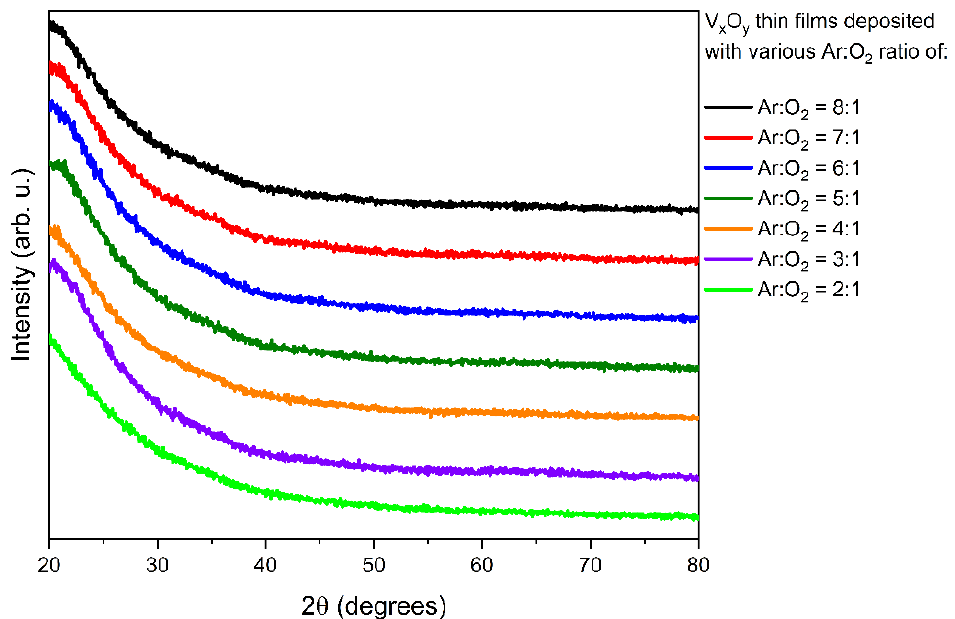
Figure 2. Diffraction patterns of vanadium oxides deposited with various Ar:O 2 gas ratios.